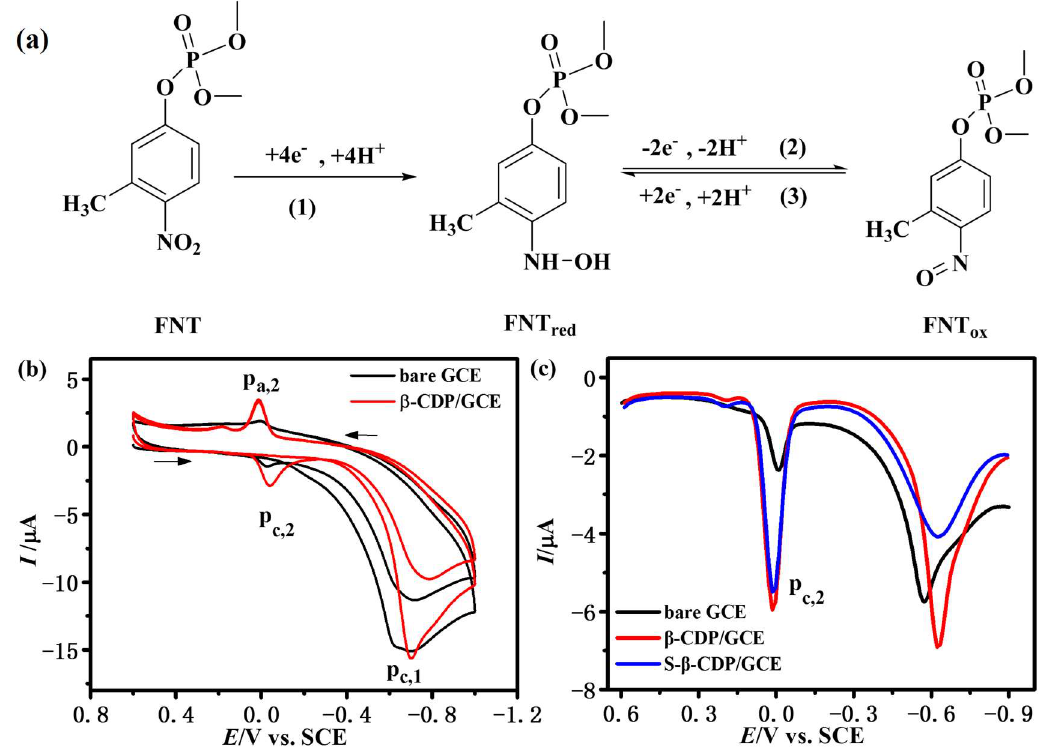
Figure 2. ( a ) The chemical structure of FNT and its electrochemical behavior; ( b ) CV curves of FNT (2 μg/mL in acetate buffer solution, pH = 5.00) on GCE and β-CDP/GCE with potential from 0.6 to −1.0 V, scan rate of 50 mV/s, and 2 cycles; ( c ) the third-step DPV curves of FNT (2 μg/mL in acetate buffer solution, pH = 5.00) on GCE (black line) and β-CDP/GCE (red line); (blue line) the third-step DPV curve of S-β-CDP/GCE (soaked in acetate buffer solution with 2 μg/mL FNT for 90 s, taken out, and rinsed with acetate buffer solution) in blank (without FNT) acetate buffer solution (pH = 5.00). DPV parameters: potential increment of 13 mV, amplitude of 50 mV, pulse width of 60 ms, sampling width of 20 ms, pulse period of 500 ms, and potential from 0.6 to −0.9 V.